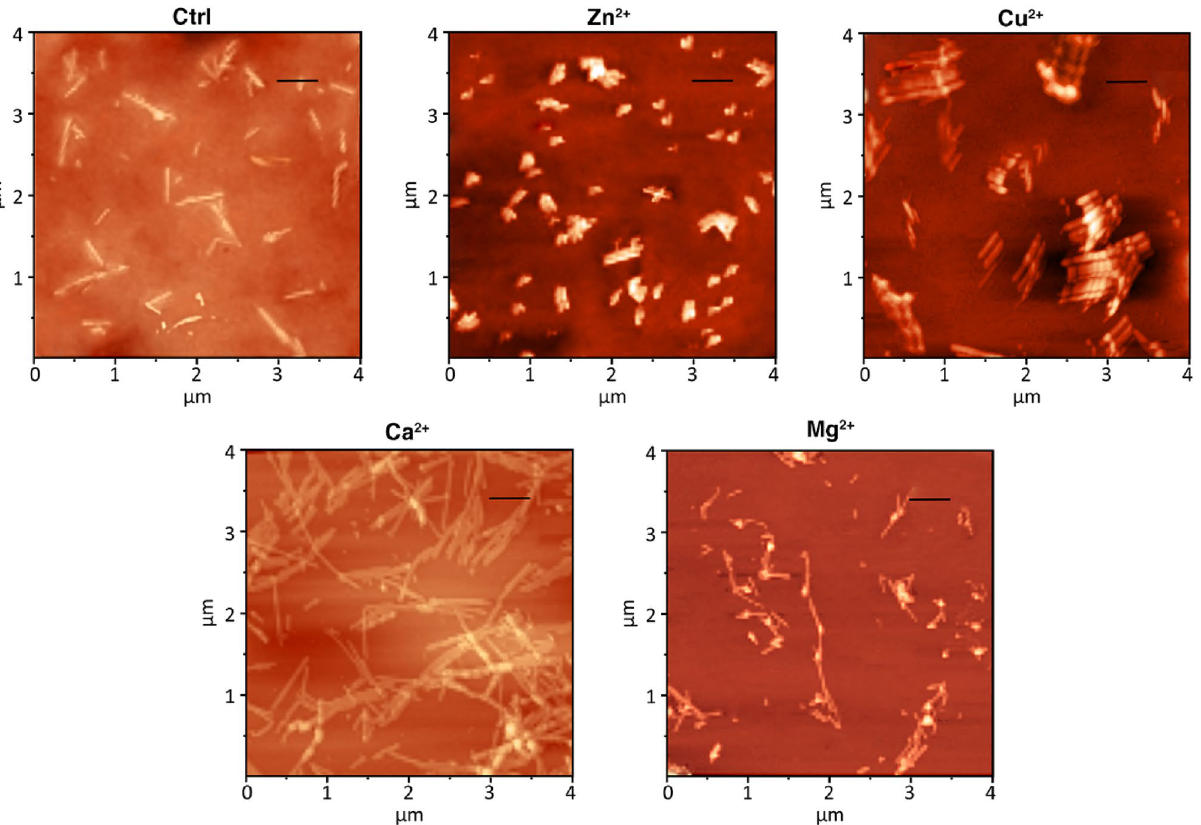
Figure 5. AFM images of α-Syn fibrils formed in the presence and absence of each studied cation. The end stage fibrils formed in Tris buffer or in the presence of Zn 2+ , Cu 2+ , Ca 2+ , and Mg 2+ were analyzed. The scale bars represent 500 nm.